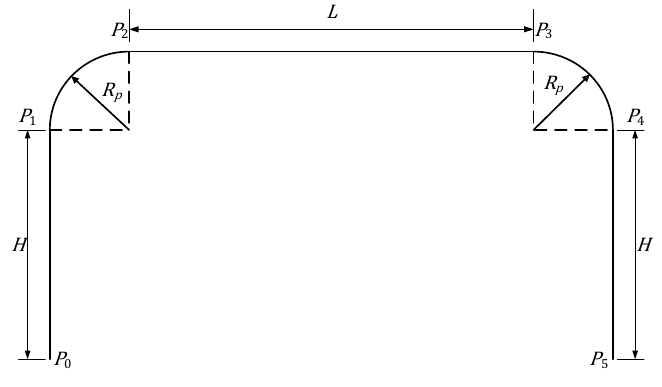
Figure 3. Door-shaped trajectory.